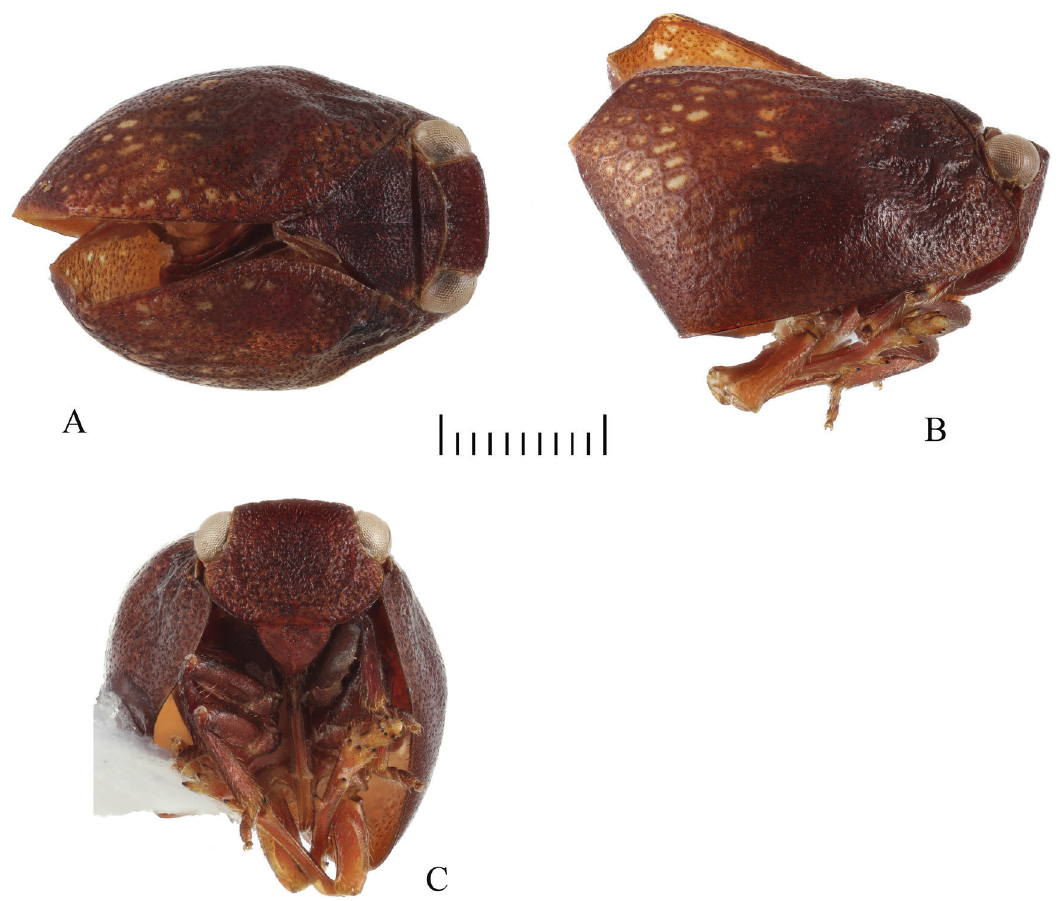
Fig. 3. Superciliaris tawaiensis sp. nov., ♂, holotype (BMNH), external view. A . Dorsal view. B . Lateral view. C . Frontal view. Scale bar = 1